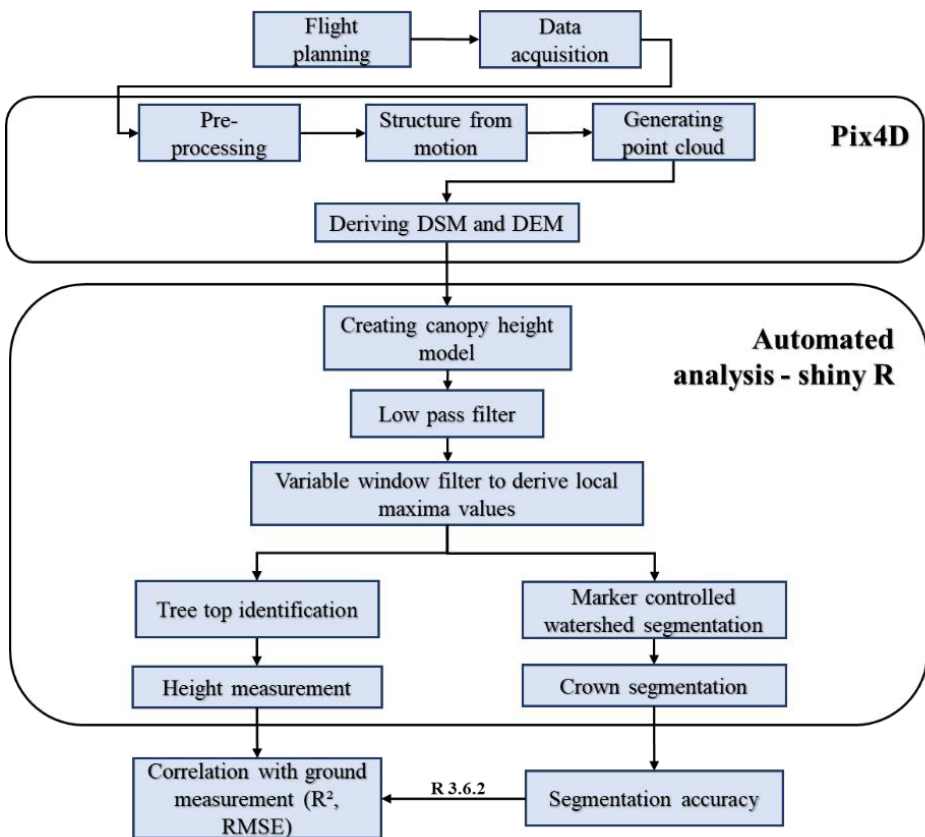
Figure 2. Workflow of tree-level information extraction using UAS-based imagery from broadleaf tree plantations.